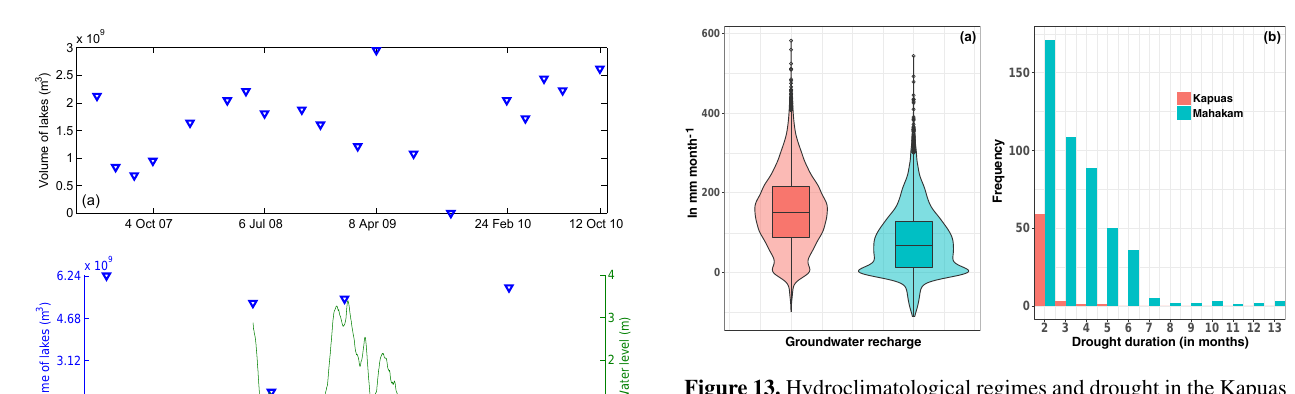
Figure 13. Hydroclimatological regimes and drought in the Kapuas and Mahakam lowlands: (a) violin and box plots showing the dis- tribution of monthly groundwater recharge over the period of the TRMM data set (1998–2014); (b) drought in groundwater recharge showing different